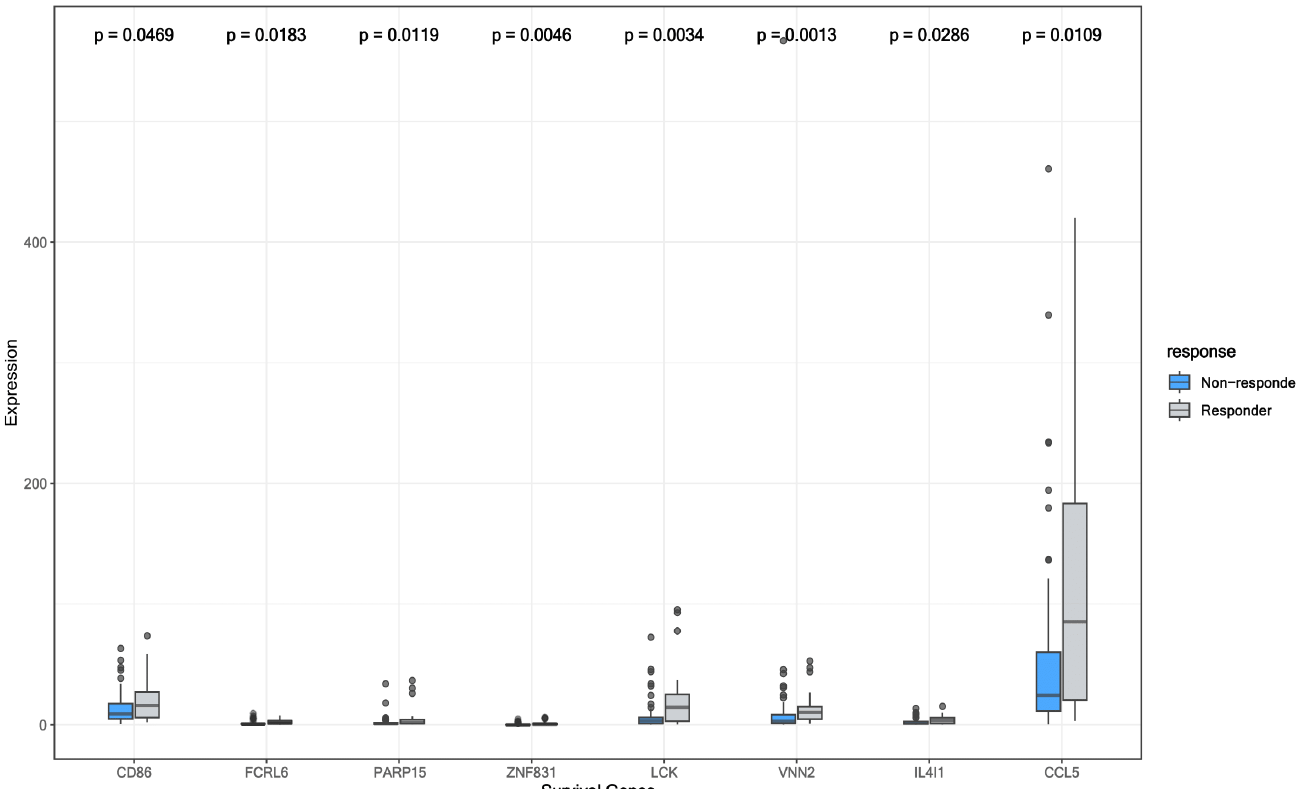
Figure 7. The expression of survival-related genes between responders and non-responders. Table 3. Univariate and multivariate cox proportional hazard model for OS.